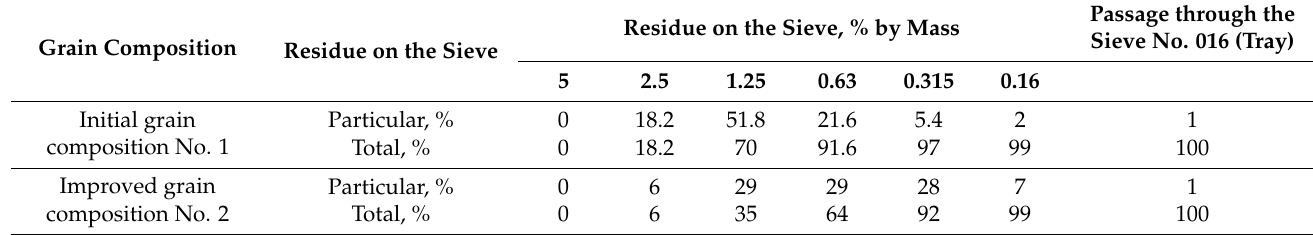
Table 1. Grain composition of rubber crumb.